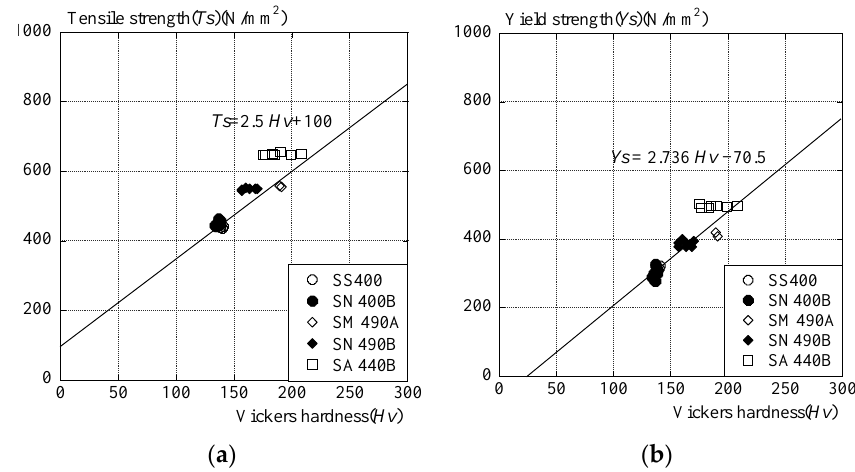
Figure 4. ( a ) Tensile strength and Vickers hardness and ( b ) yield point or yield strength and Vickers hardness.